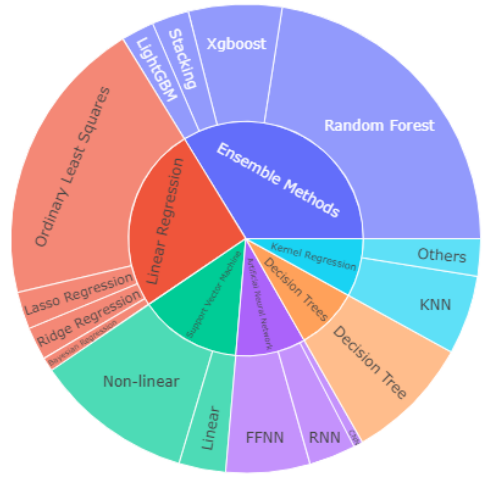
Figure 3. Sunburst chart of bibliometric analysis methods used in data-drive building energy